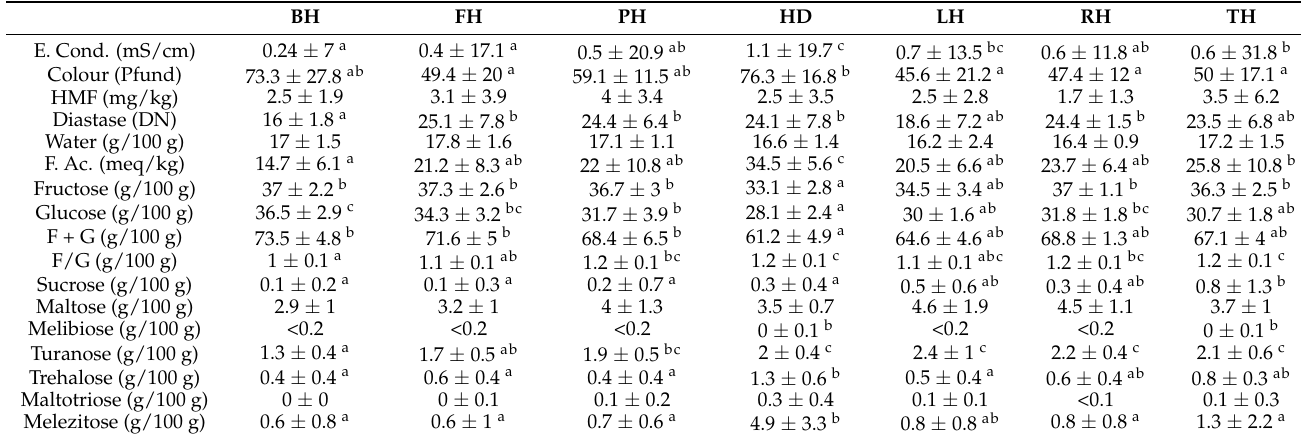
Table 2. Physico-chemical parameters of Czech